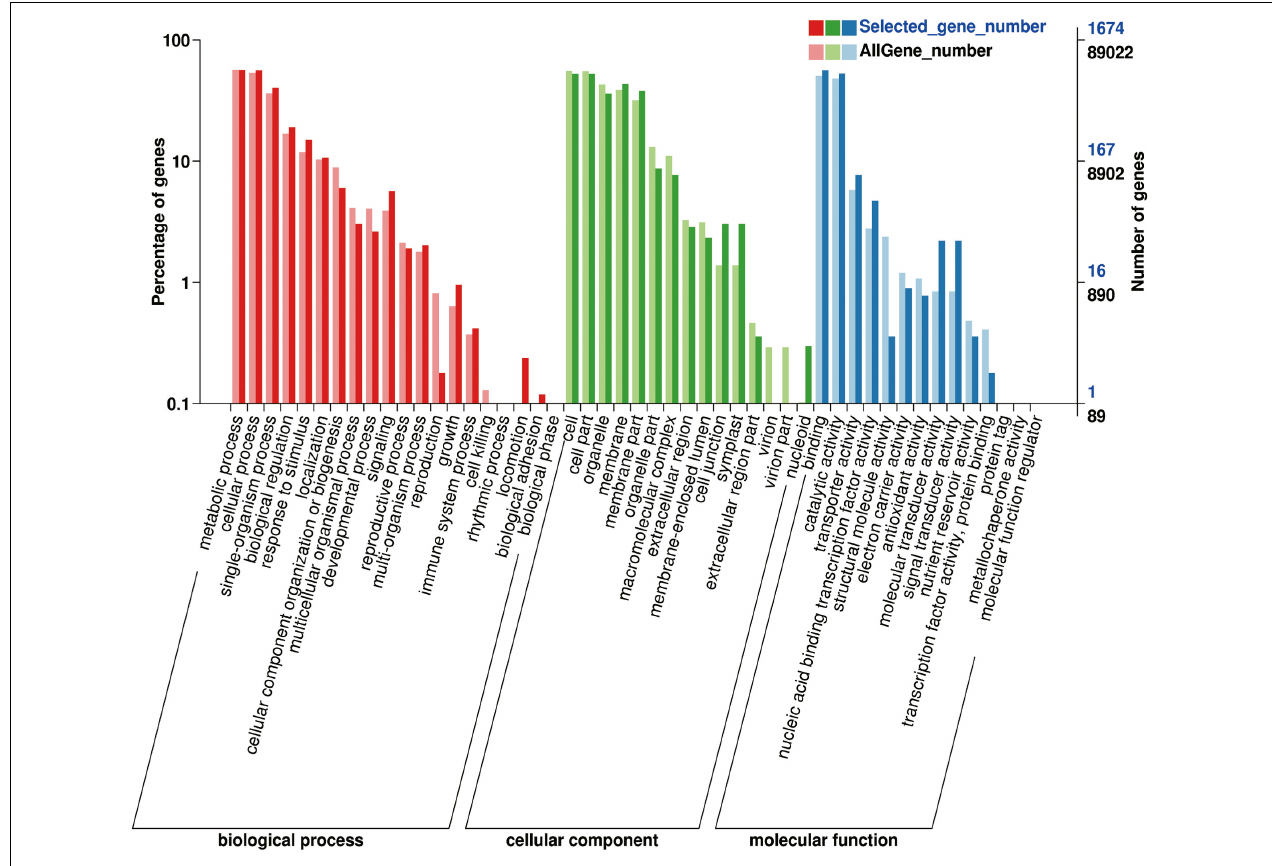
FIGURE 9 | Biological function GO enrichment analysis of 1,991 differentially expressed